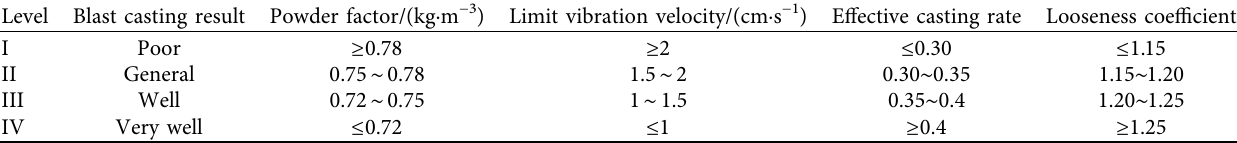
Table 1: The grading standards of quantitative indicators for evaluating blast casting results.